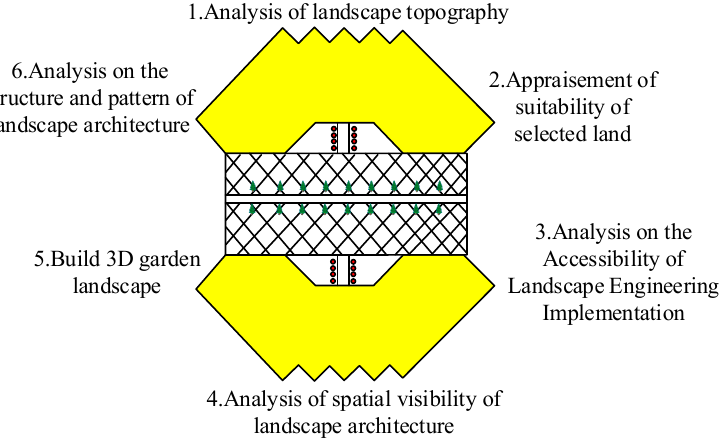
Figure 2. Multi-dimensional analysis content of GIS in landscape architecture.